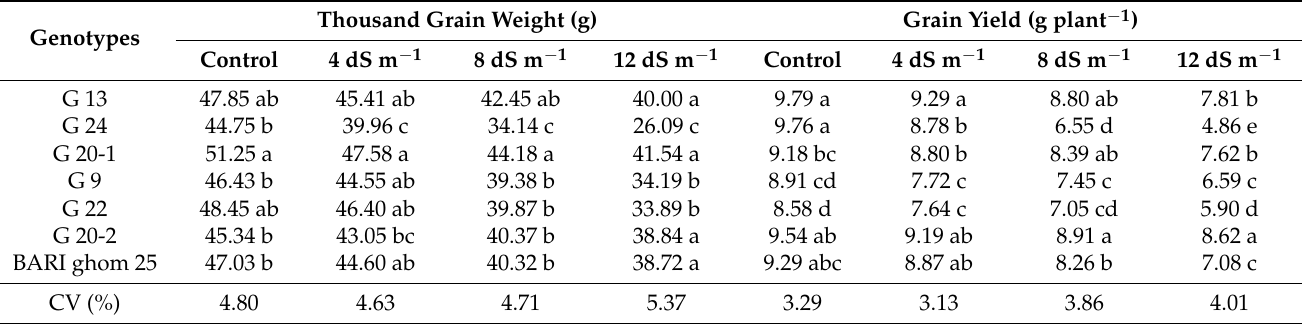
Table 4. Thousand grain weight and grain yield of wheat genotypes under different salinity